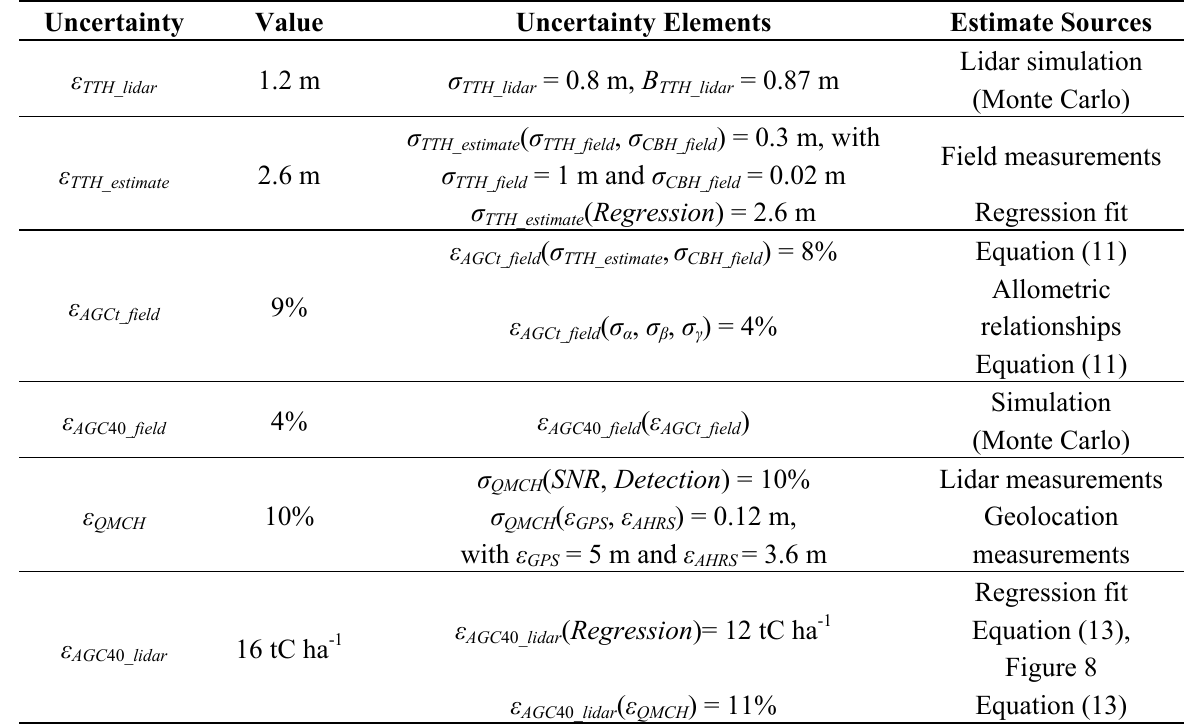
Table 4. Synthesis of uncertainties ( ε ) and their assessment sources a